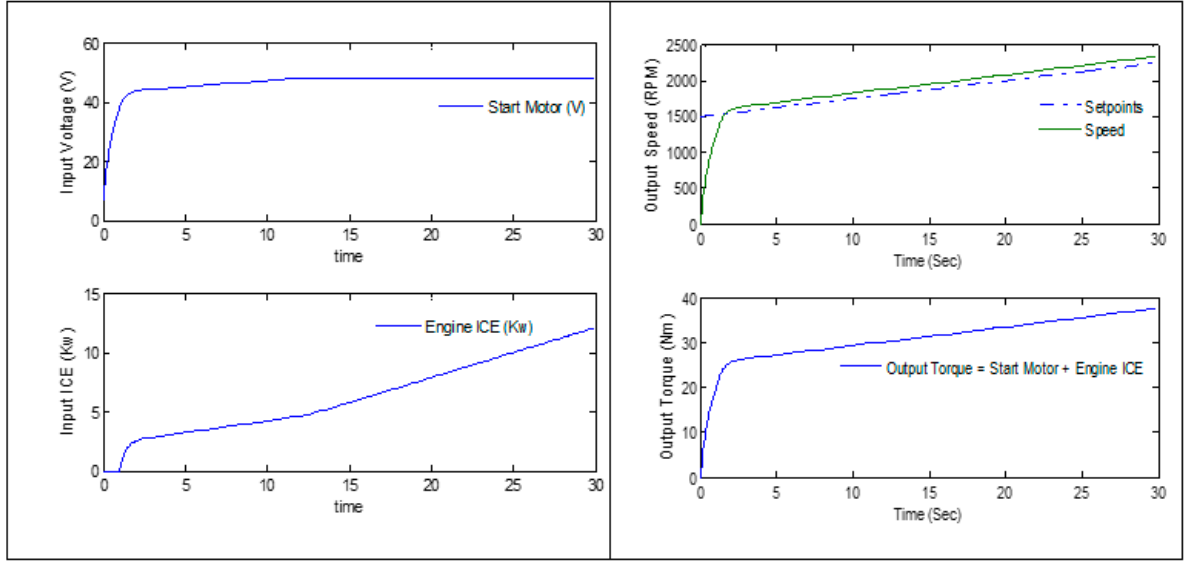
Figure 9. The MPC for the HEV with ICE and ME2.